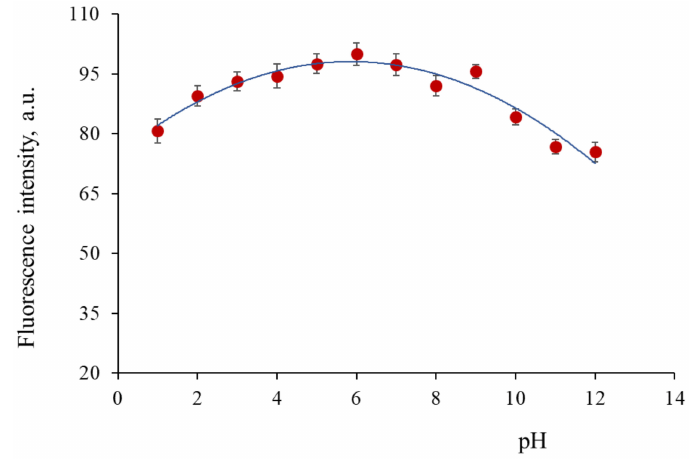
Figure 5. Fluorescence intensity changes upon pH variation in